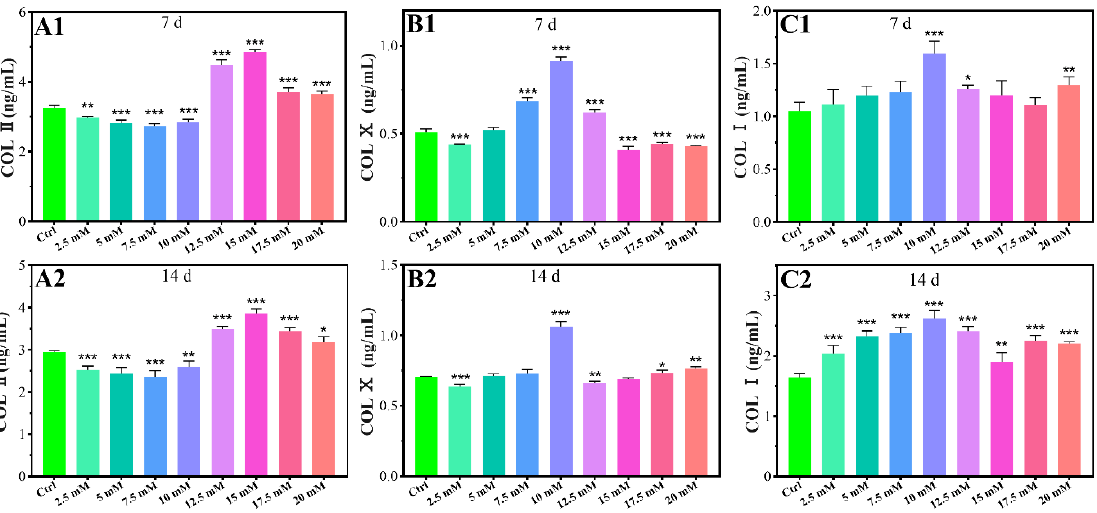
Figure 3. Effects of protein contents of chondrocytes cultured in different Mg 2+ concentrations on the 7th day ( A1 , B1 , C1 ) and the 14th day ( A2,B2 , C2 ), all data were presented as mean ± SD, * p < 0.05, ** p < 0.01, and *** p <